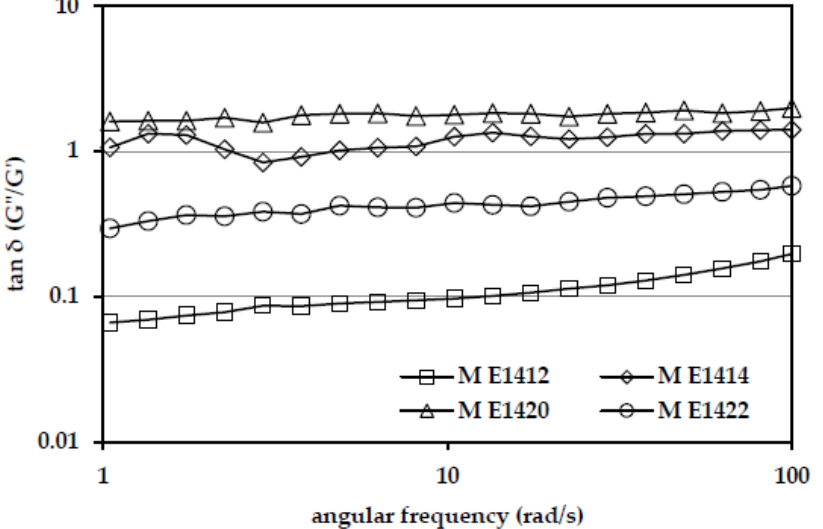
Figure 4. The values of the tangent of the phase angle (δ) depending on the angular frequency for the emulsion stabilized with selected DE 6 maltodextrins at different concentrations (M E1412 — 30%; M M E1414, M E1422—40%; M E1414, M E1422 — 40%; M E1420 — 50%).